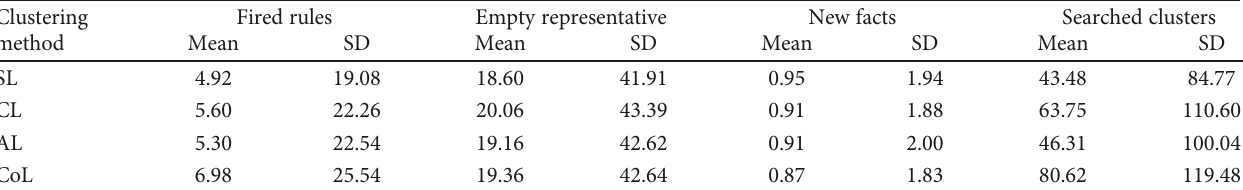
Table 7: Description of inference e ffi ciency vs. clustering methods.